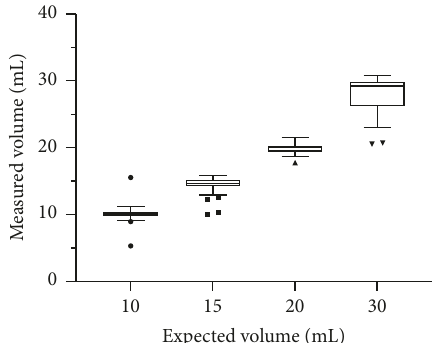
Figure 4: Tukey box and whisker plot of expected vs. measured maximum indicating the volume of dosing cups ( n � 167, 38, 16, and 17 for 10mL max , 15mL max , 20mL max, and 30mL max , respectively).